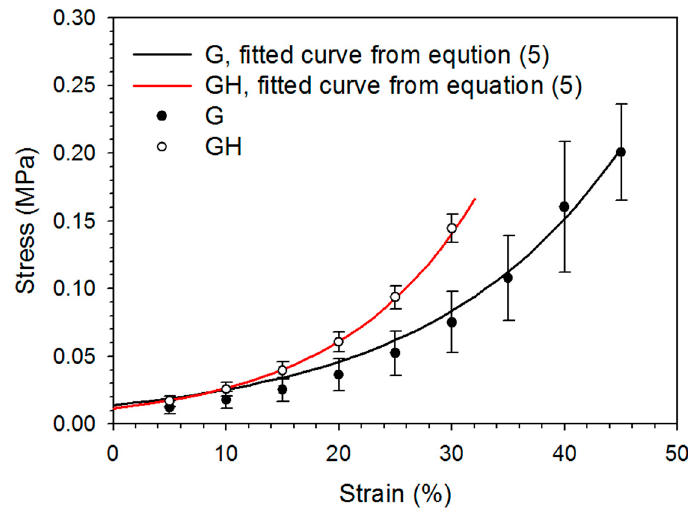
Figure 2. The water uptake kinetics in phosphate buffered saline (PBS) ( A ) and degradation kinetics in collagenase ( B ) of G and GH cryogels.